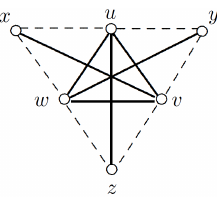
Figure 1: A red-blue subgraph in K 6